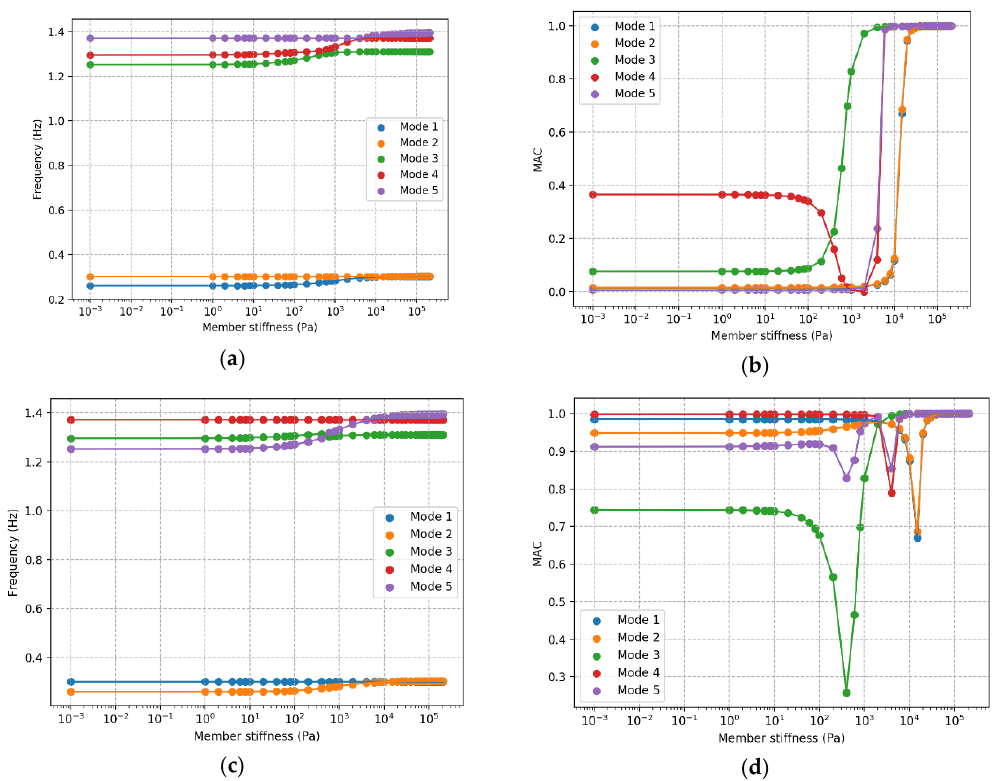
Figure 8. MAC values for the first five modes as simulated damage to a leg element is implemented. ( a ) Mode frequency value; ( b ) MAC value, both with comparison based on mode frequency; ( c ) mode frequency value; ( d ) MAC value, both with comparison based on maximized MAC values.